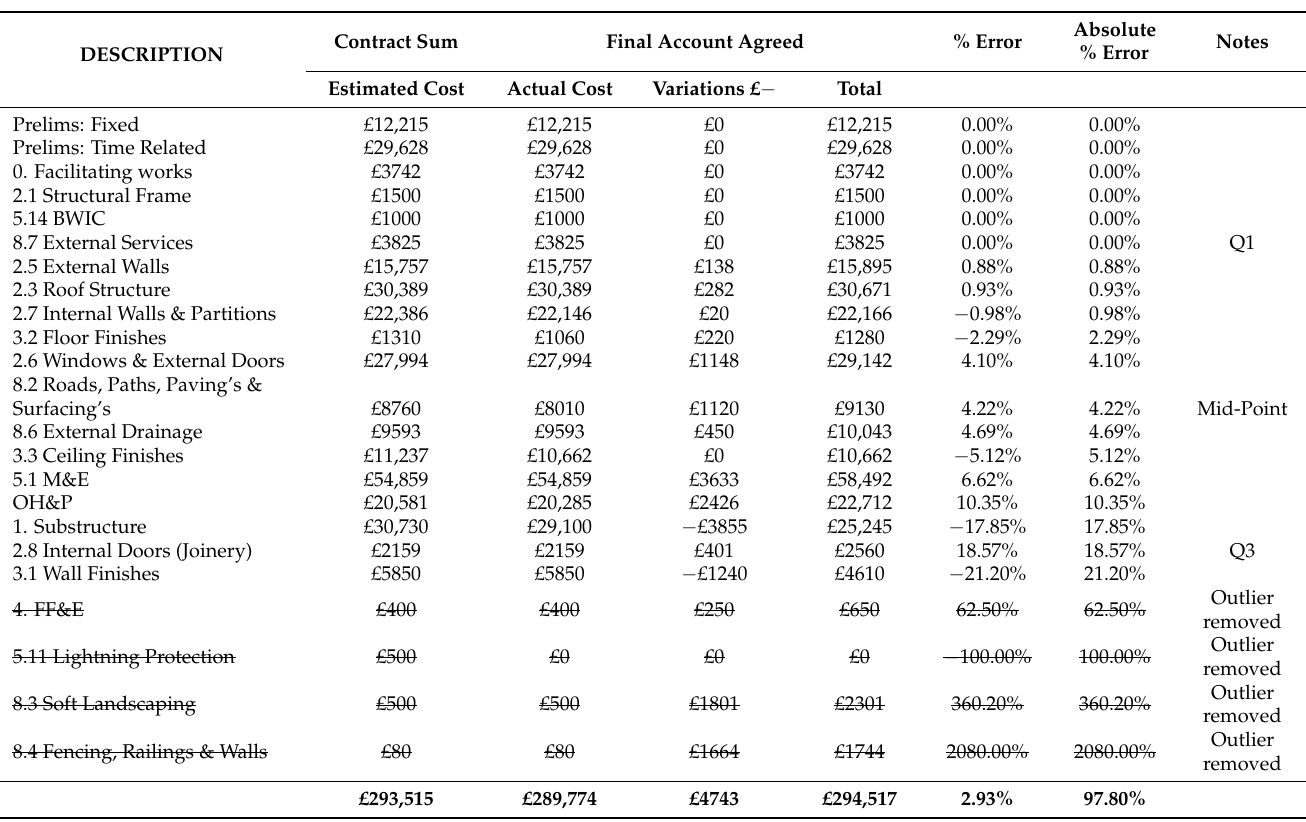
Table 8. Outlier, MPE, and MAPE